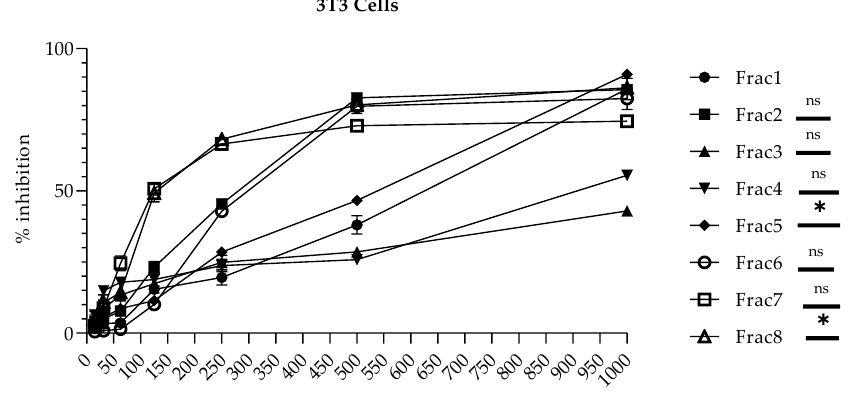
Figure 1. Cytotoxicity of M. inermis and T. indica fractions on 3T3 cell Line: No significant difference: ns , p > 0.05; significant differences: *, p < 0.05. Frac1 : decoction of M. inermis leaves; Frac2 : additional ethyl acetate + butanol + acetone fractions of M. inermis leaves; Frac3 : additional ethyl acetate + acetone fractions of M. inermis stem; Frac4 : additional ethyl acetate + acetone fractions of M. inermis root; Frac5 : additional ethyl acetate + butanol fractions of T. i ndica leaves; Frac6 : acetone fraction of T. indica leaves ; Frac7 : additional ethyl acetate + acetone fractions of T. i ndica stem; Frac8 : additional ethyl acetate + acetone fractions of T. indica root; M. inermis , Mitragyna inermis ; T. indica , Tamarindus indica .